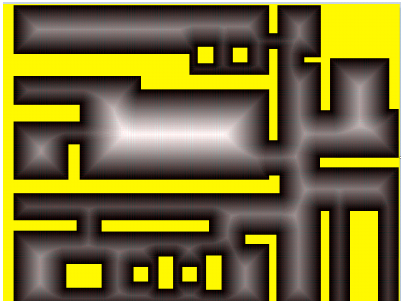
Figure 1. A distance map (DM) constructed from an indoor environment. The yellow regions consist of blocked cells (obstacles). Visually speaking, for each of these traversable cells in the unblocked areas, the father it is away from the nearest obstacle, the higher its brightness is.